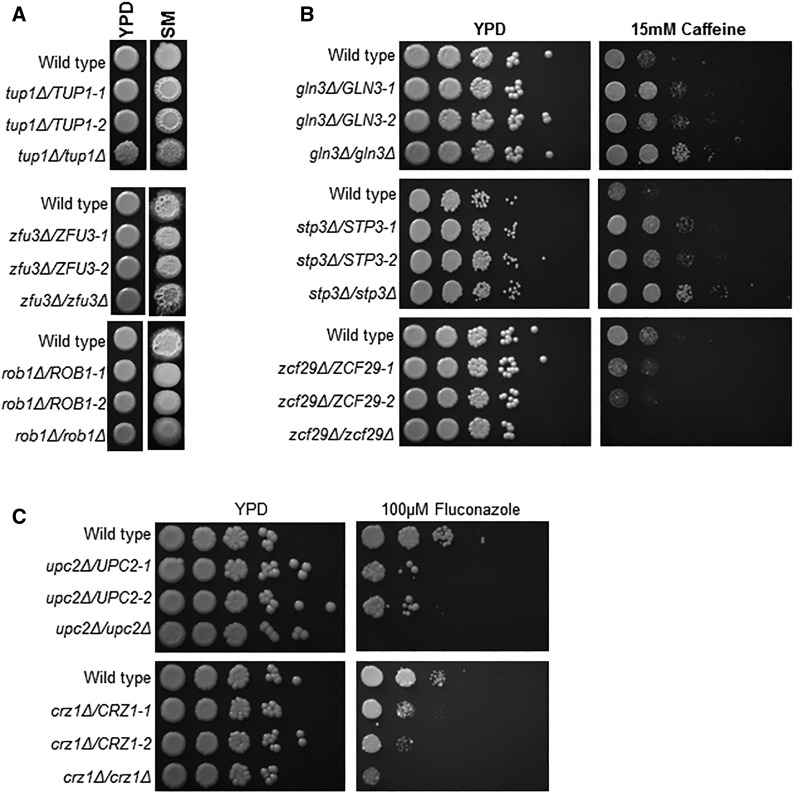
Representative haploinsufficent and haploproficient strains. Ten-fold dilution series of the indicated strains were spotted on agar plates and incubated at either 37°C (A) or 30°C for 1-3 days and photographed. Two independent isolates of each heterozygous strain were plated as noted by -1 and -2. A. The indicated strains were plated on YPD (yeast peptone dextrose) and SM (Spider medium). B. The strains were plated on YPD and YPD+15 mM caffeine. C. The indicated strains were plated on YPD+1%DMSO and YPD+1%DMSO+fluconazole.